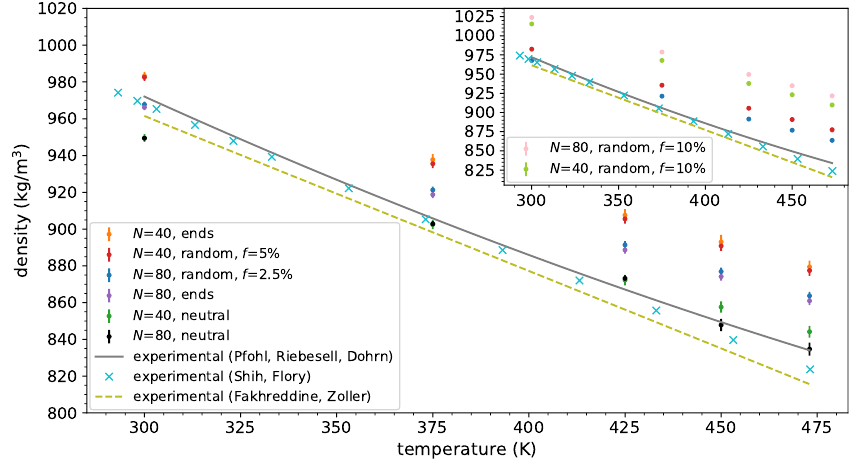
Figure 2. Density of (ionic) PDMS melts by simulations for various N and charged monomer fraction f , and by experiments. (i) Solid line: experimental values available from [93], (ii) cross symbols, experimental values taken from [94], (iii) dashed line: experimental values by [95], (iv) magenta symbols: end-functionalized N = 80, (v) orange symbols: end-functionalized N = 40, (vi) red symbols: randomly functionalized N = 40, f = 5%, (vii) blue symbols: random N = 80, f = 2.5%, (viii) green symbols: neutral N = 40 melt, (ix) black symbols: neutral N = 80 melt. Inset: (i) green symbols: random N = 40, f = 10%, (ii) pink symbols: random N = 40, f =